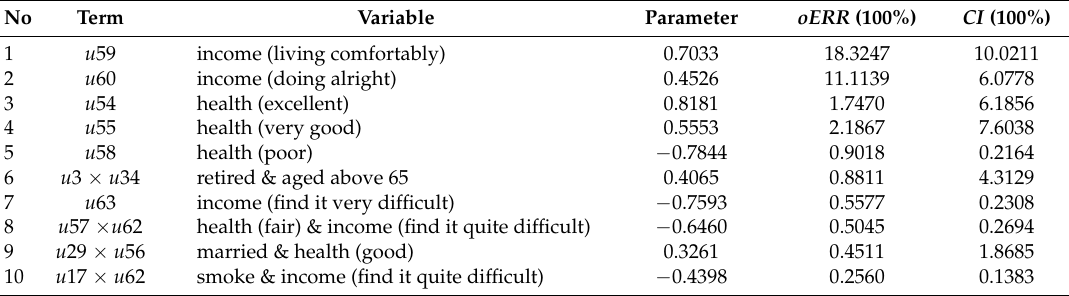
Table 3. Nonlinear